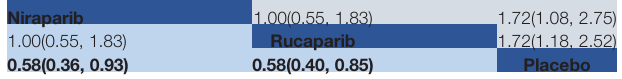
TABLE 6 | The network meta-analysis of PFS in HRD-negative patients.